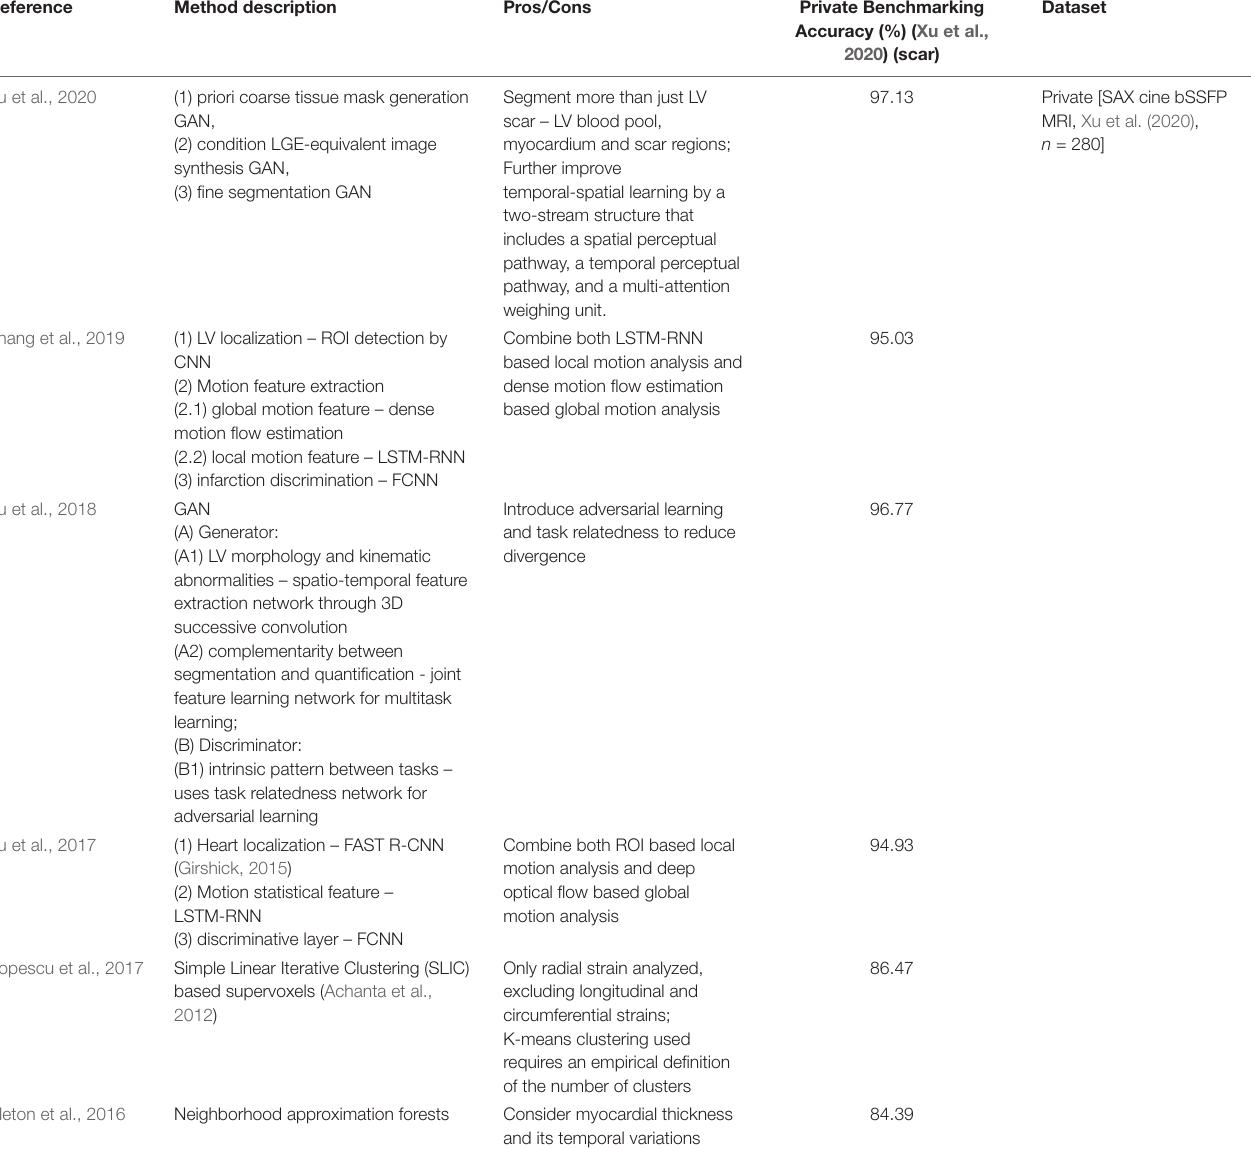
TABLE 8 | Summary of representative machine learning/deep learning based scar segmentation in cine MRI for segmentation of cardiac scar regions on cine bSSFP